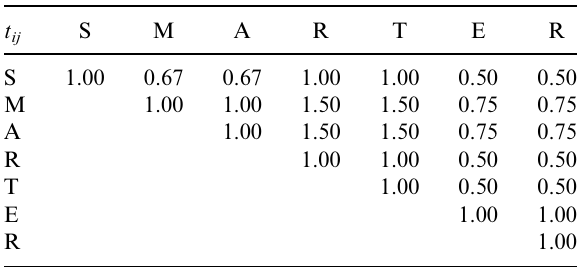
Table 7. Pair-wise weights for the AHP model for selecting KPIs